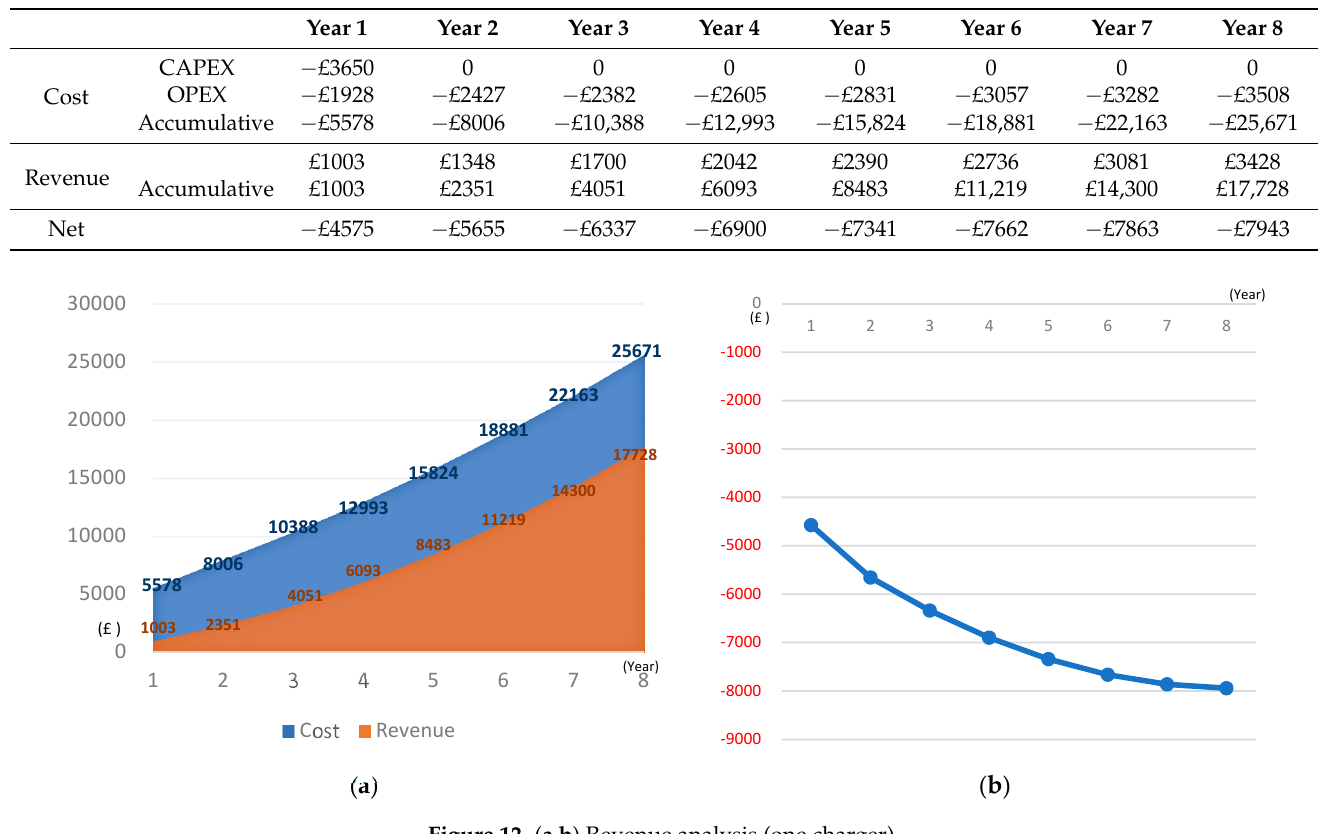
Figure 12. ( a , b ) Revenue analysis (one charger). Table 19. Cost and revenue of PCS in County Durham (one charger) in GBP.